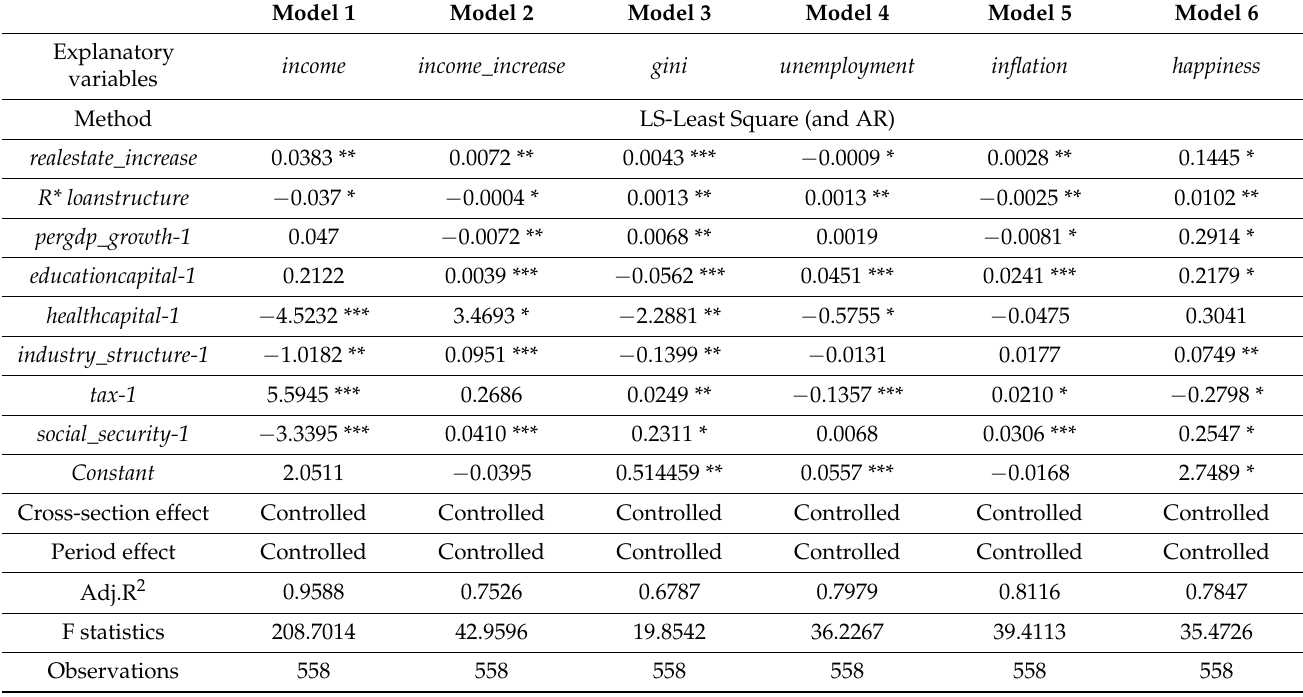
Table 3. LS test results of real estate investment growth on national happiness through loan structure.